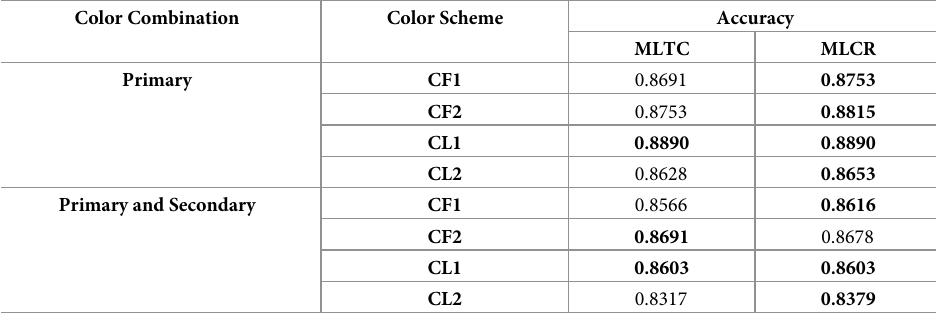
Table 7. Accuracy of MLTC and MLCR method on each color